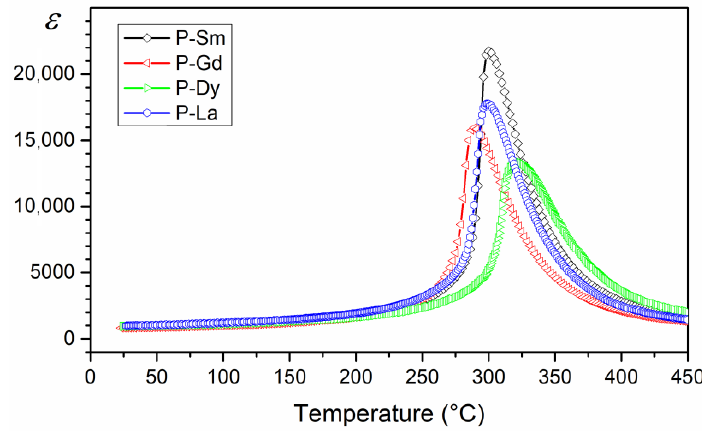
Figure 7. Comparison ε ( T ) graph for the four multicomponent PZT-type materials (for 1